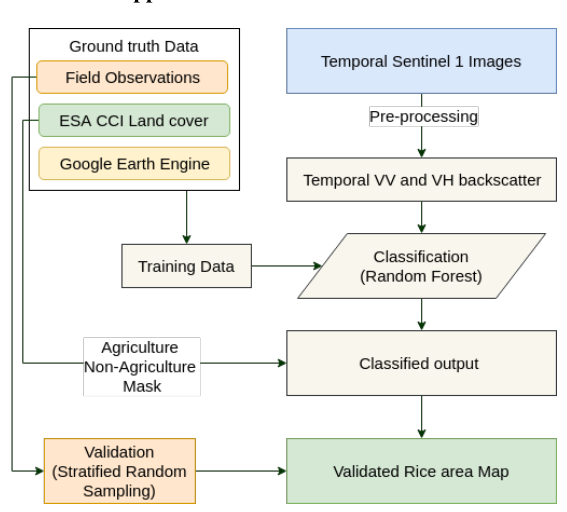
Figure 2. Rice Area Mapping Framework